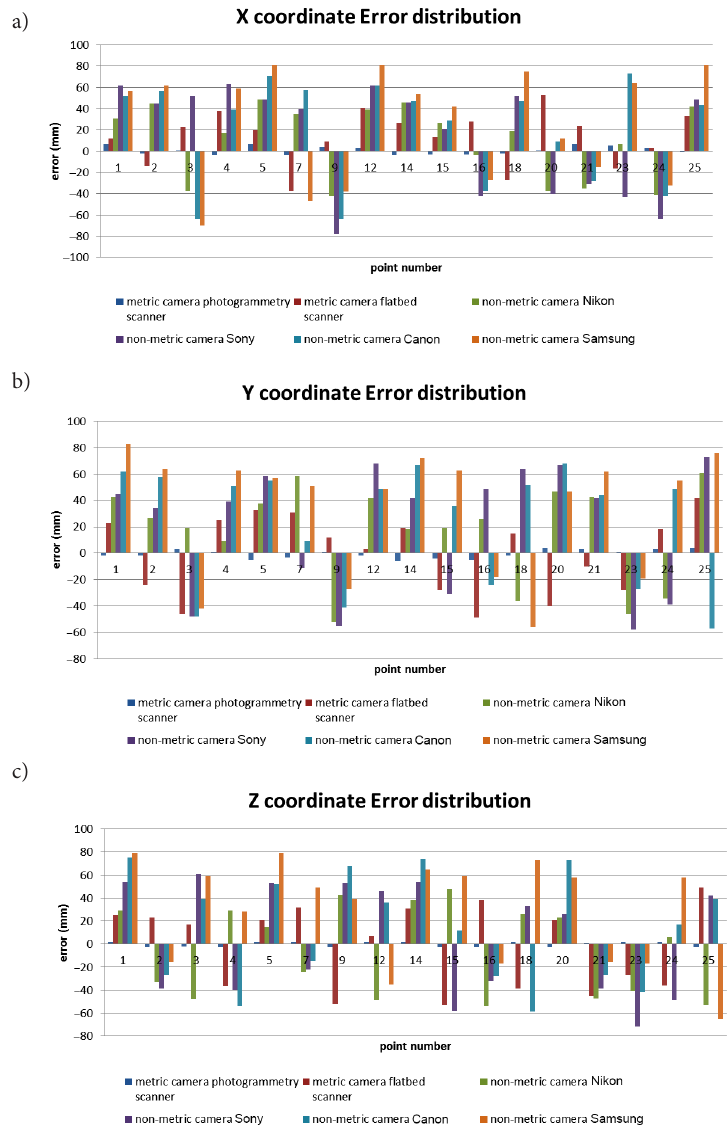
Figure 12. Differences of check points in X , Y , Z axis between total station observations and coordinates from metric and non-metric cameras